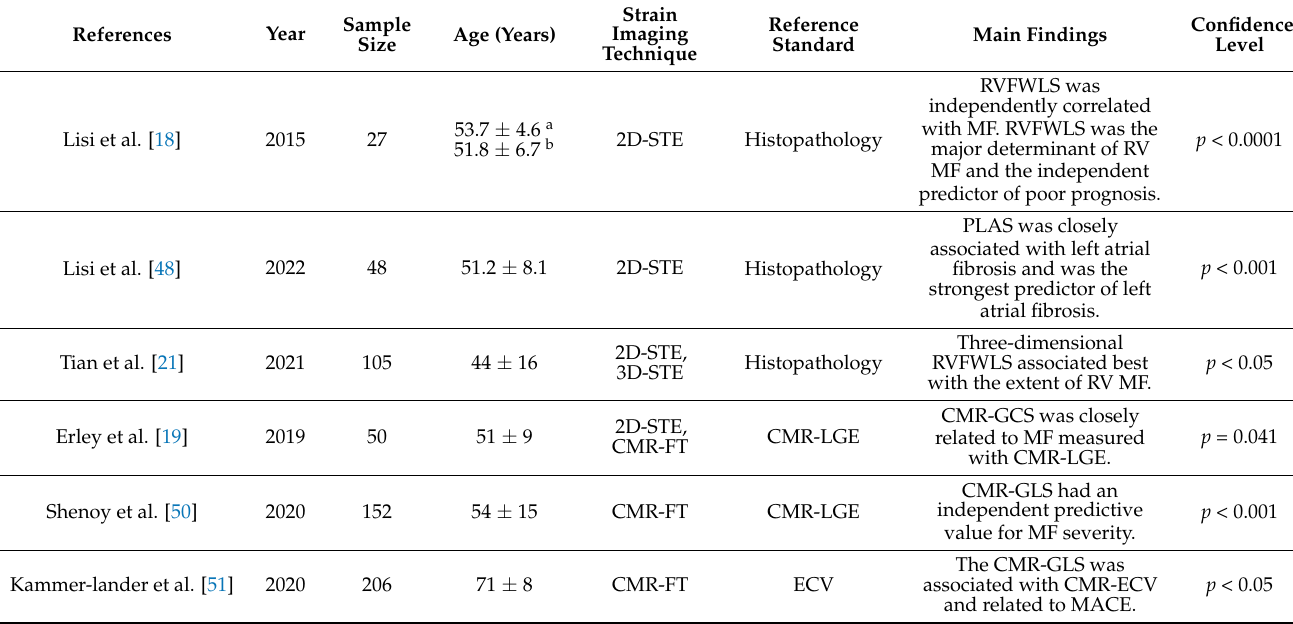
Table 1. Evaluation of MF in HF patients using strain